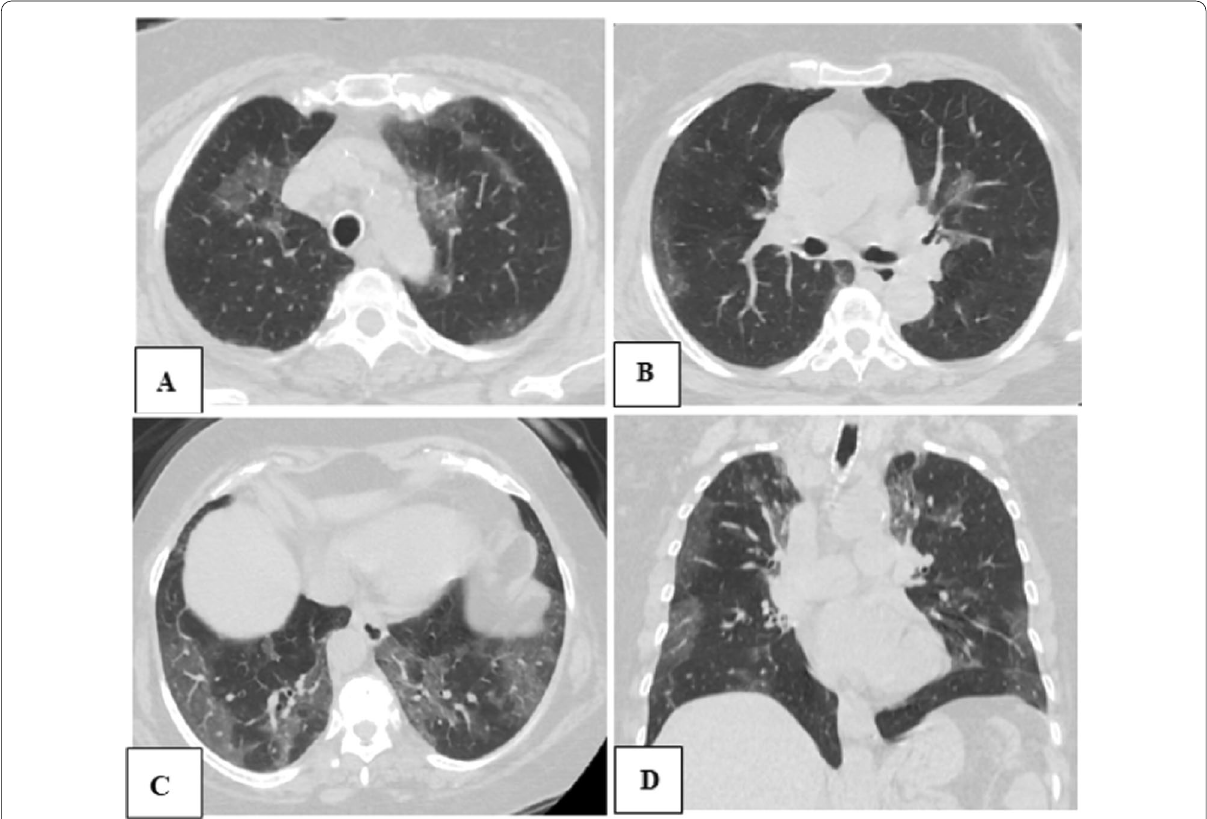
Fig. 2 68-years old female patient, with blood group AB, having COVID-19 pneumonia, and referred for CT chest assessment. A – C Axial and D coronal CT chest images shows bilateral sub-pleural variable-sized ground-glass opacities with interlobar septal thickening. Calculated CT severity score was 15 and such case was considered moderate